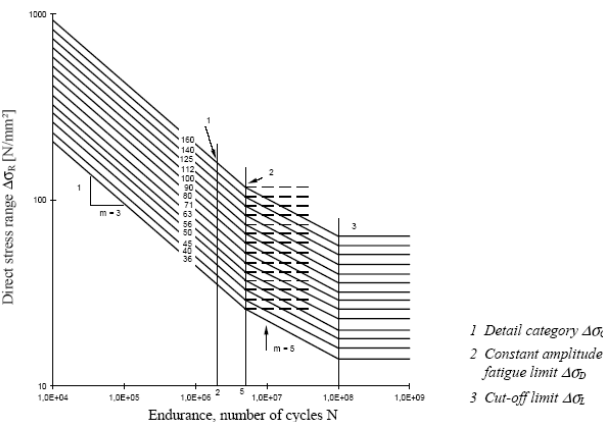
Figure 1: Fatigue strength curves for direct stress ranges (Eurocode3, 2004).